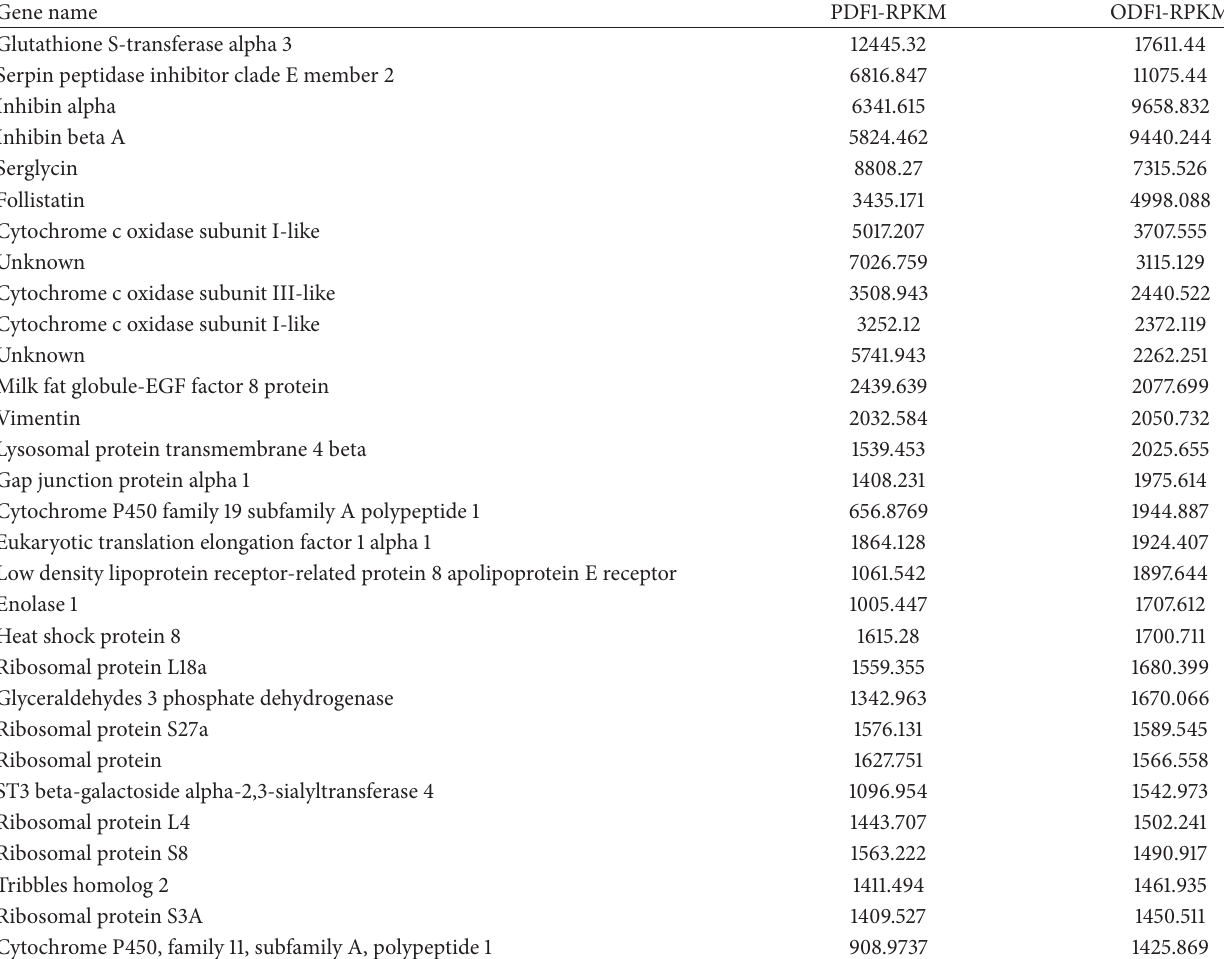
Table 1: Top 30 highly expressed genes in ODF1 and PDF1 follicles.